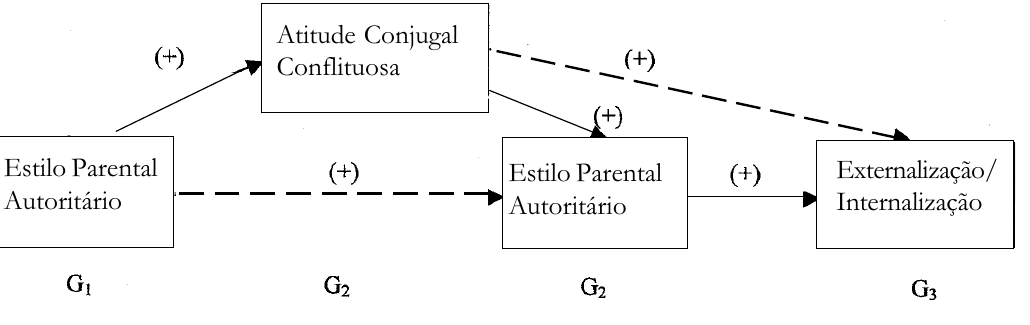
Figura 1. Modelo longitudinal mediativo de risco